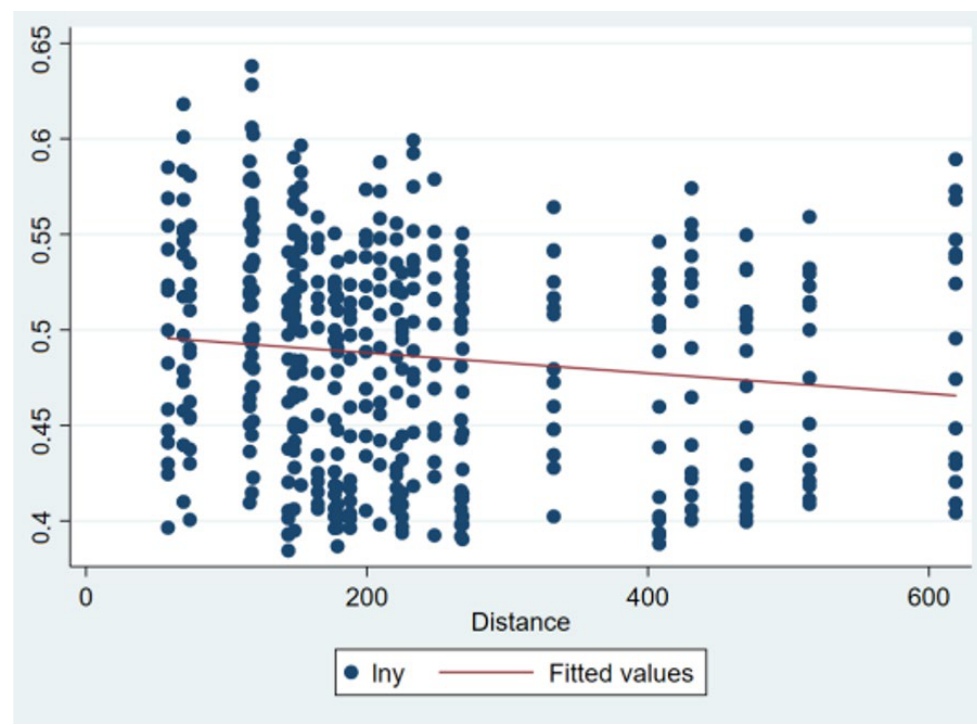
Figure 2. Graph dependent variable and distance scatter graph.